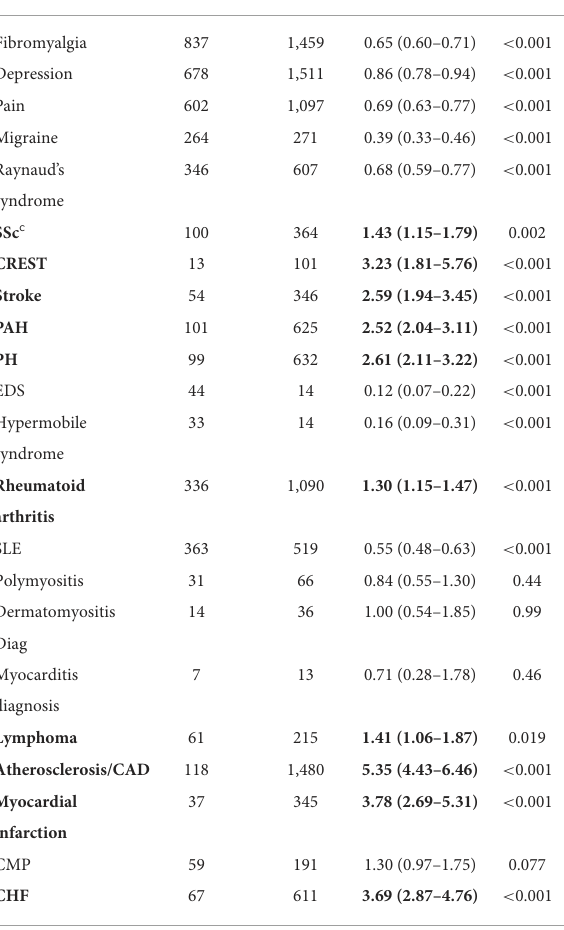
TABLE 12 Relative risk of developing a comorbidity in patients with Sjögren’s disease that are ≥ 50 years of age ( n = 13,849). Comorbidity